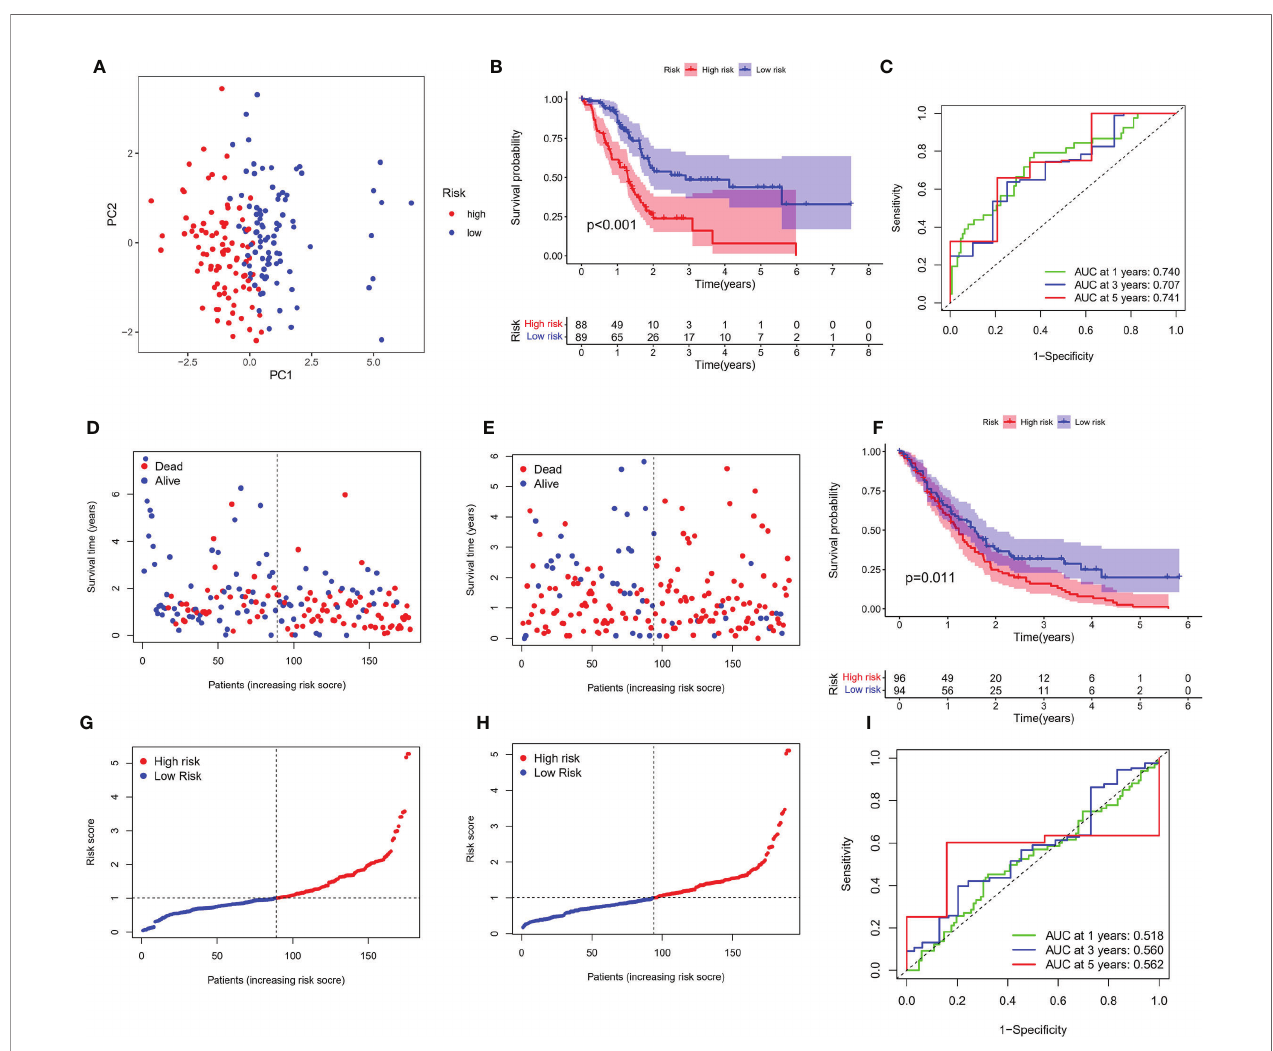
FIGURE 3 | Veri fi cation of risk score. (A) PCA map for PC in TCGA cohort. (B) Kaplan – Meier curves for comparison of PC risks between low-PC and high-PC risk groups. (C) ROC curves illustrating the risk score prediction ef fi ciency. (D) Each patient ’ s survival rate is shown in TCGA cohort (low-PC risk cluster: on the left side of the dotted line; high-PC risk class: on the right side of the dotted line). (E) The survival rate for each patient in TCGA cohort (low-PC risk group: on the left side of the dotted line; high-PC risk class: on the right side of the dotted line). Patient distribution on the basis of the risk score. (F) Each patient ’ s survival rate is shown in GEO cohort. (G) The survival rate for each patient in TCGA cohort. (H) Kaplan – Meier curves for comparison of PC risks between low-PC and high-PC risk groups. (I) ROC curves illustrating the risk score prediction ef fi